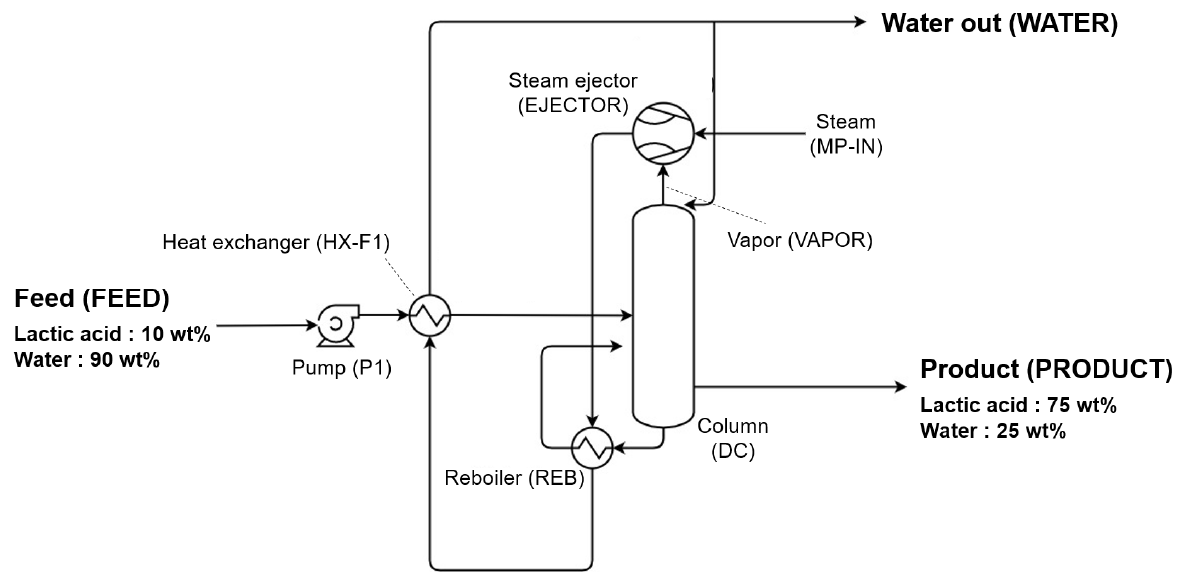
Figure 3. Simplified diagram of alternative process model using TVR.